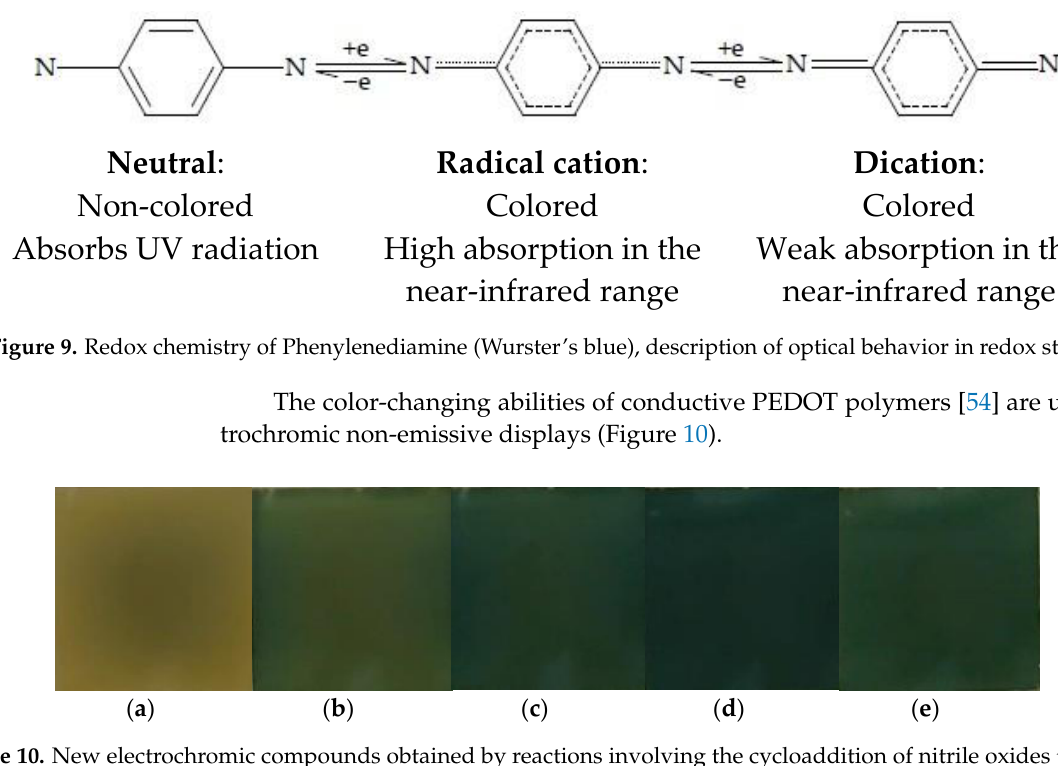
Figure 10. New electrochromic compounds obtained by reactions involving the cycloaddition of nitrile oxides to 1,2-bis (4-pyridinyl) ethylene derivatives (electrochromic transition): ( a ) — neutral state; ( b – e ) — oxidized states.